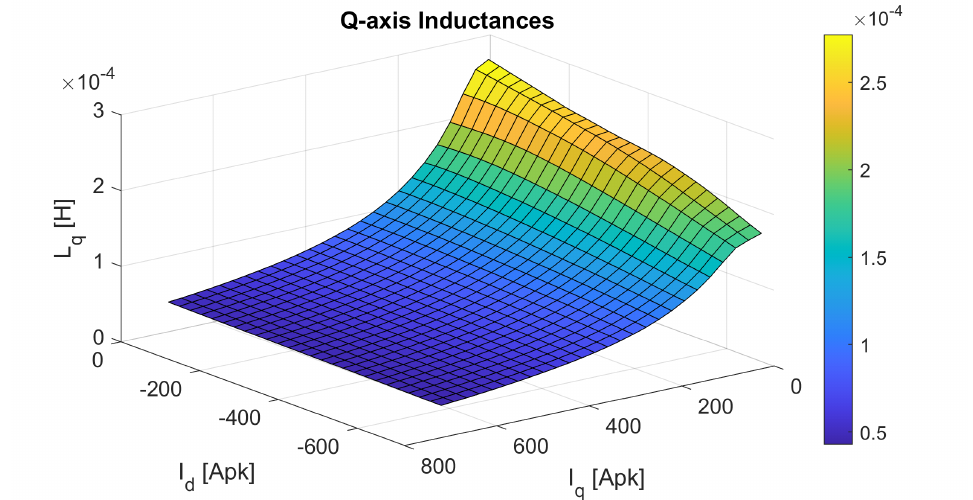
Figure 6. Inductance map of q -axis ( L q ) obtained with the Frozen Permeability